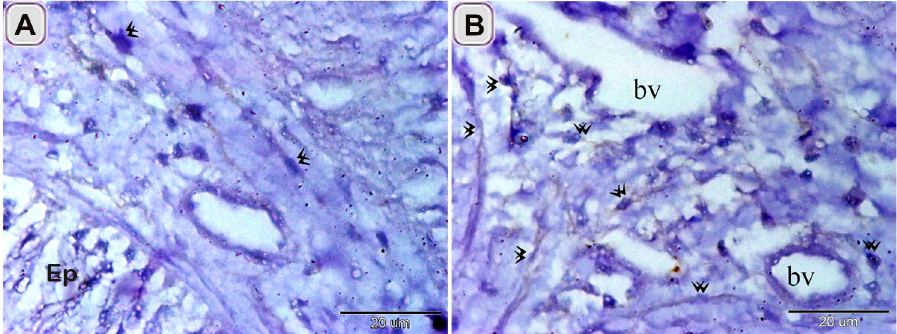
Figure 8. Immunohistochemical staining of the intestinal blub using CD34. Immunostained paraffin sections of the intestinal blub for CD34. counter stain by HX A: CD34 TCs (double arrowheads) in the subepithelial layer